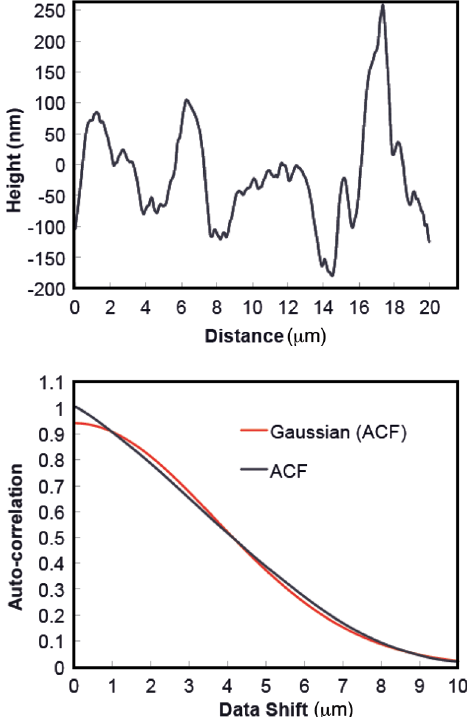
FIG. 13. Height variation and autocorrelation function for one of the image scans. The red line is the best fit to a Gaussian autocorrelation function. The autocorrelation coefficient for this fit is T ¼ 5 . 2 μ